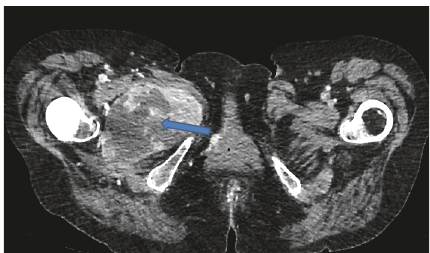
Figure 2: CT scan of the pelvis showing a cystic lesion in close prox- imity to the femoral stem suggesting an inflammatory